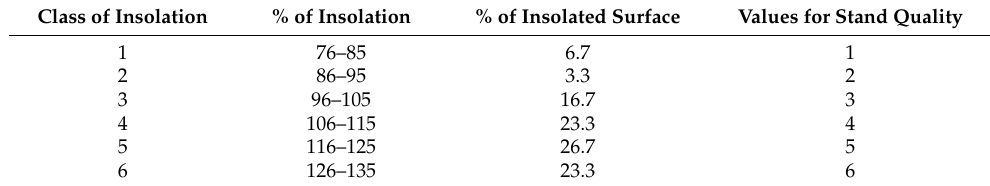
Table 1. Relative insolation classes in years